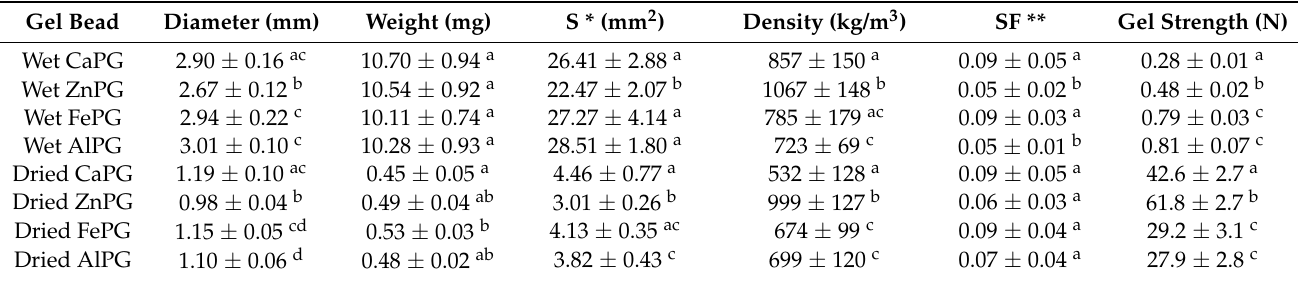
The mean force overtime curve obtained using the compression test of the gel beads is shown in Figure 2. The gel strength was determined as a force measured when the probe reached 0.5 mm after the start of sample compression. Cations influenced the gel strength of the wet gel beads in the following order (the weakest) Ca 2+ < Zn 2+ < Fe 3+ ~Al 3+ (strongest). The gel strength of the wet CaPG beads was 2.8 times lower than the wet FePG and AlPG beads (Table 1). However, the dried FePG and AlPG beads were the least strong among the dried beads, whereas the ZnPG beads were the